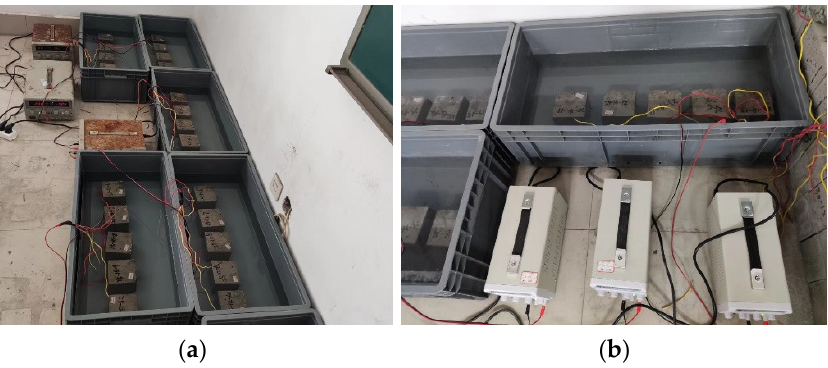
Figure 2. Test device. ( a ) The test piece is immersed in water; ( b ) Corrosion test of steel bar electri-